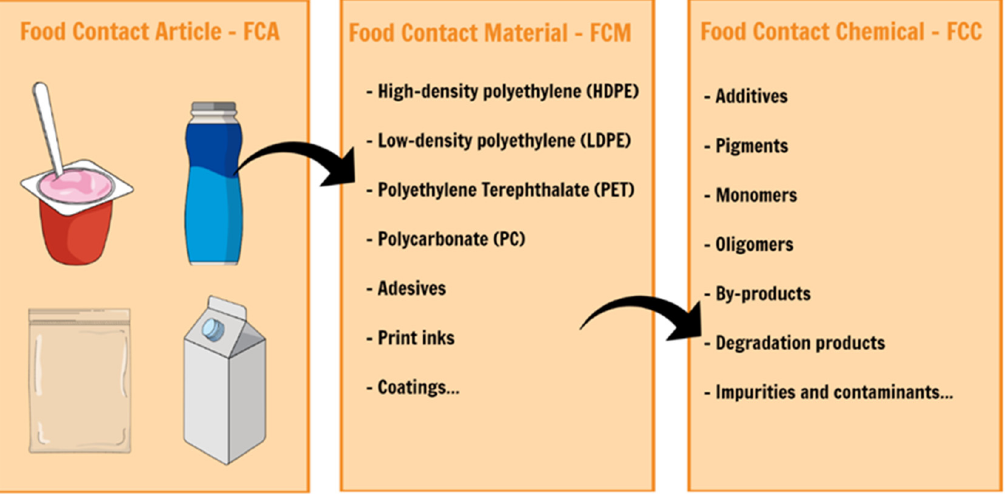
Figure 2. Illustration of key terms: FCA, FCM and FCC, and everything that makes up a food plastic packaging (adapted from Muncke et al. [23]).